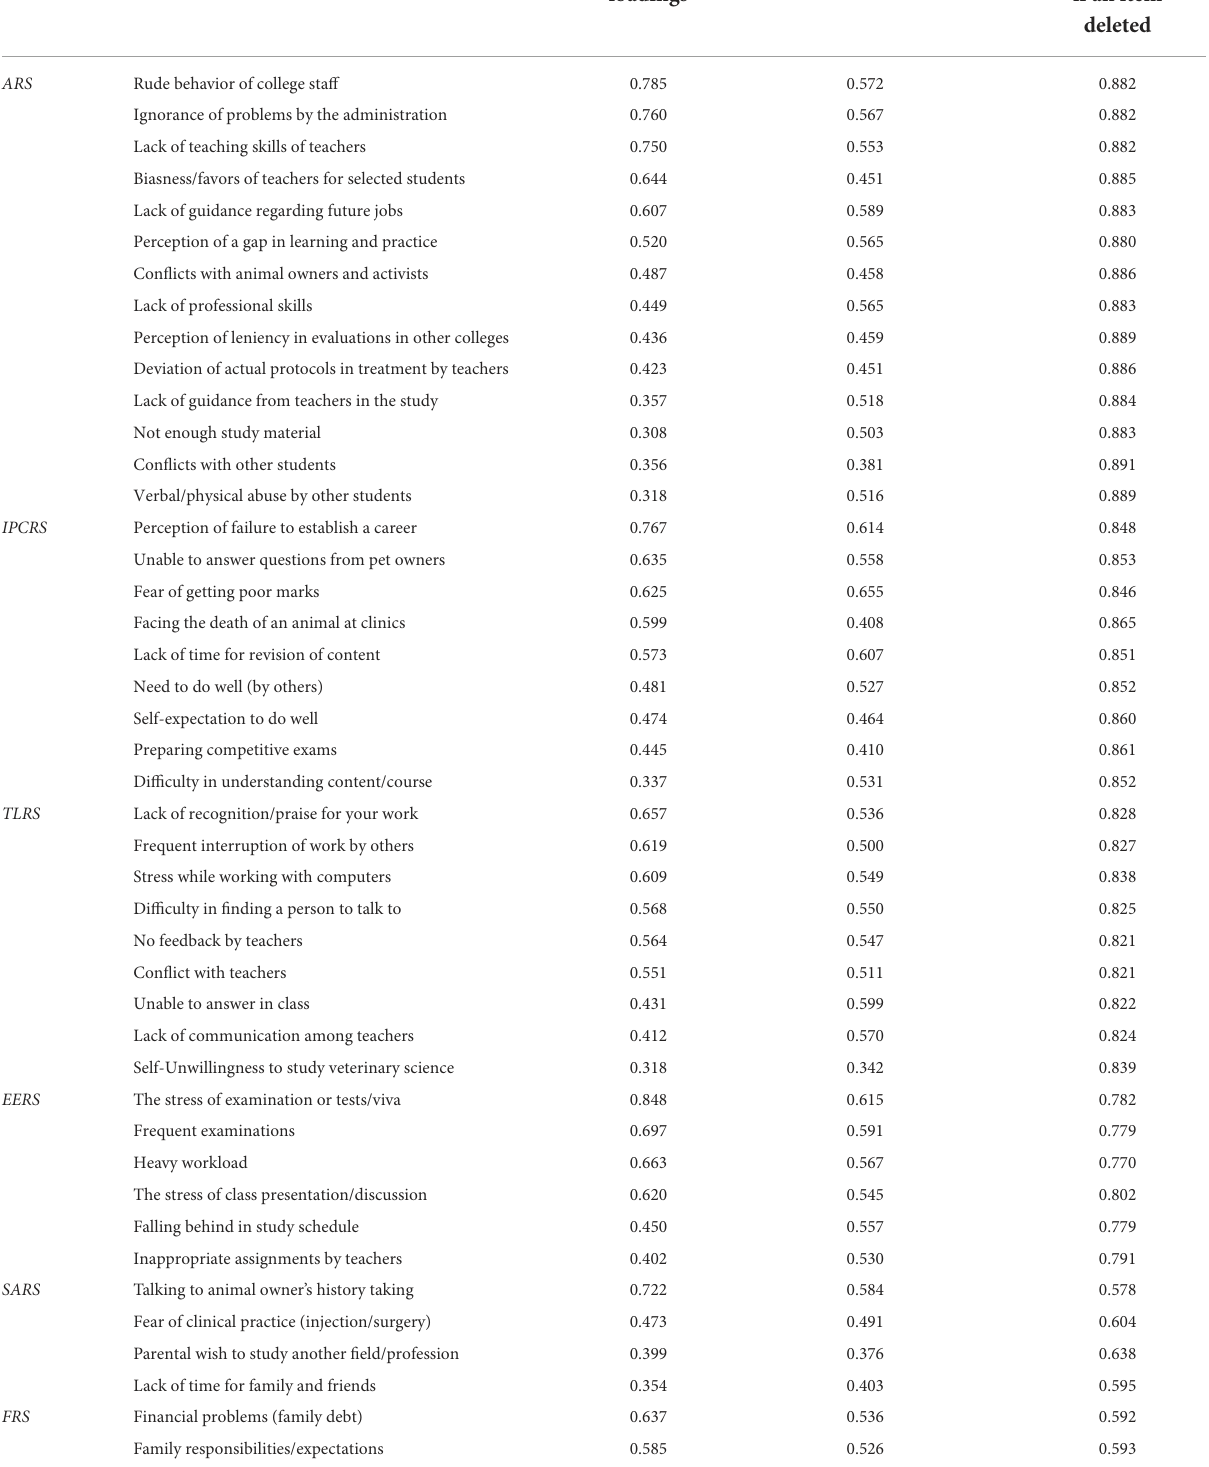
TABLE 2 Loading of variables on factor from the Promax rotation matrix. Item label under factors